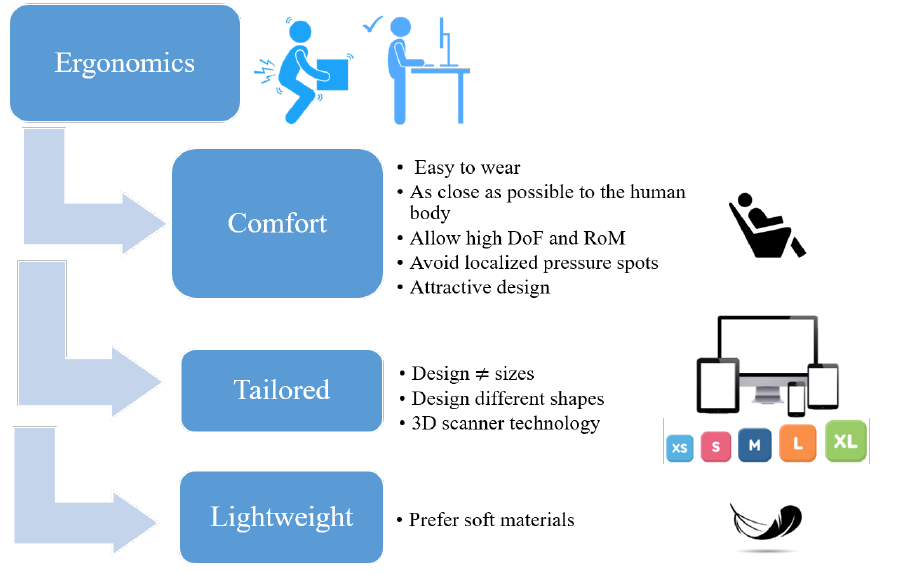
Figure 14. Ergonomic requirements for wrist